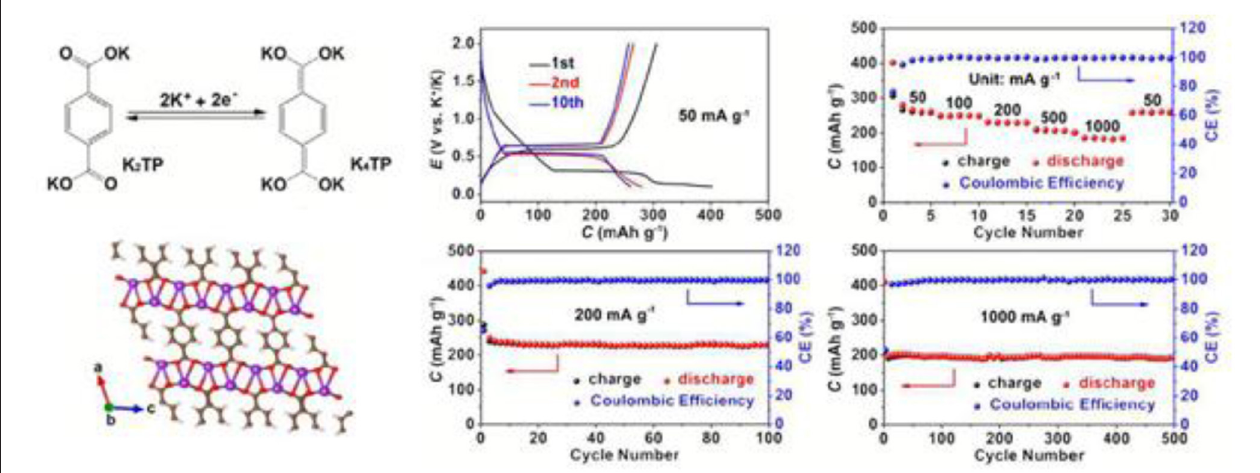
FIGURE 8 | On left, reversible K + insertion into K 2 TP and layered structure of K 2 TP; on right, electrochemical performance of K 2 TP-based electrode with KPF 6 (1M) in DME electrolyte. Adapted from Lei et al. (2017) with permission from the Royal Society of Chemistry.